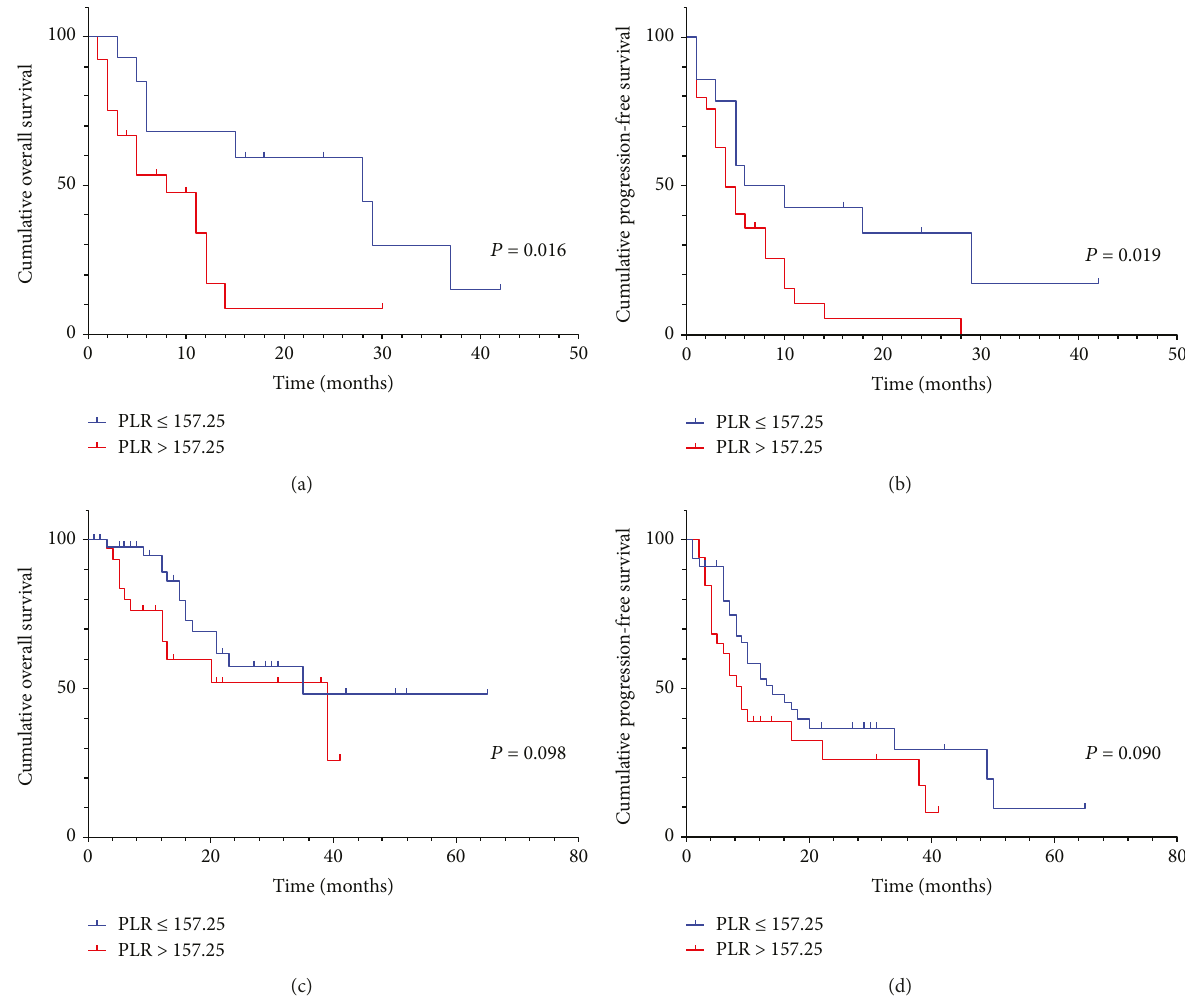
Figure 5: (a, b) Kaplan – Meier curve for OS and PFS of 39 positive surgical margin patients strati fi ed by PLR. (c, d) Kaplan – Meier curve for OS and PFS of 80 negative surgical margin patients strati fi ed by